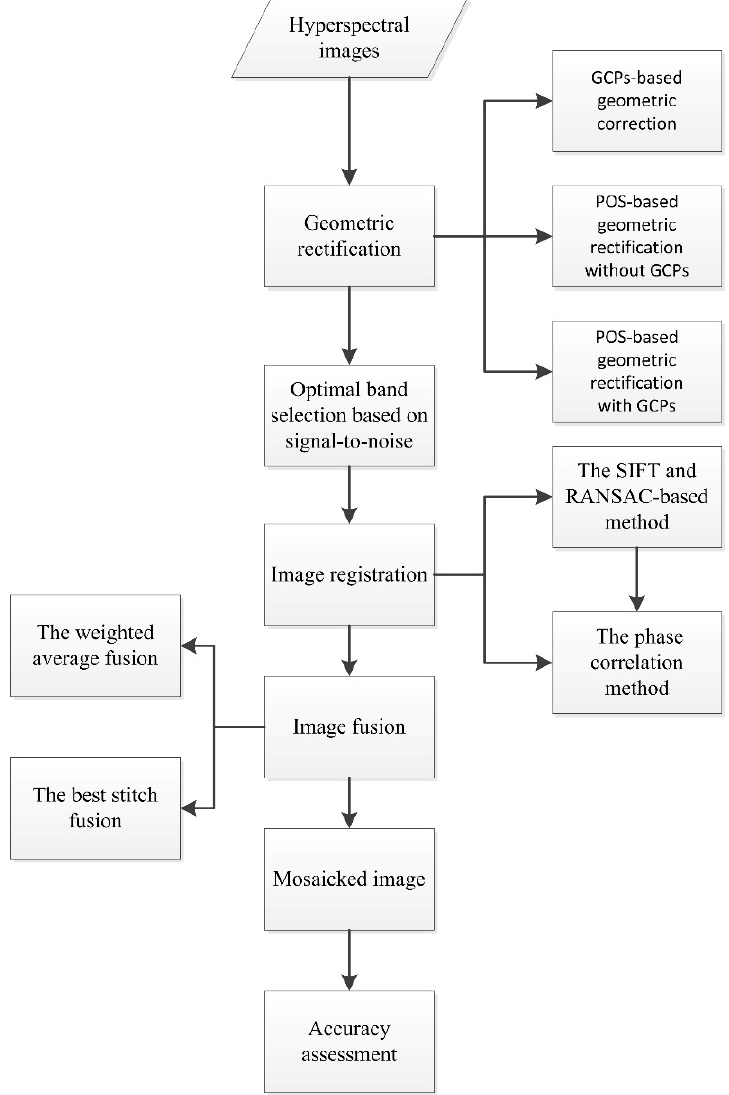
Figure 4. The image mosaicking chain.